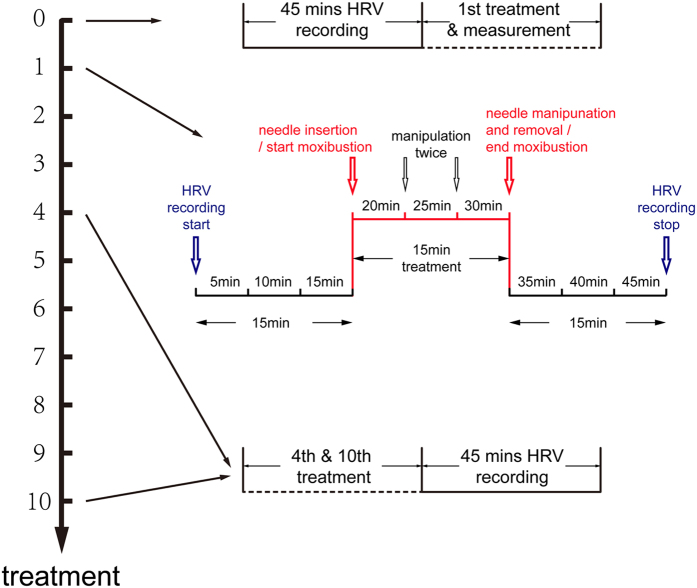
Procedure of Treatment & Measurement.